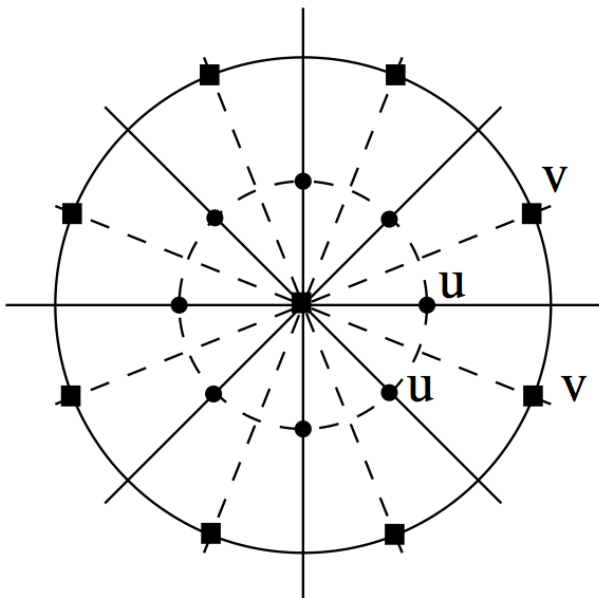
Figure 1. Schematic depicting arrangement of winds around a pole in the latitude–longitude grid. Zonal wind components, u , are used Fig. 1. Schematic depicting arrangement of winds around a pole in to determine a horizontal wind vector at the pole, using a least- the latitude-longitude grid. Zonal wind components, u , are used to squares best fit to an assumed solid-body determine a horizontal wind vector at the pole, using a least-squares best fit to an assumed solid-body rotation.